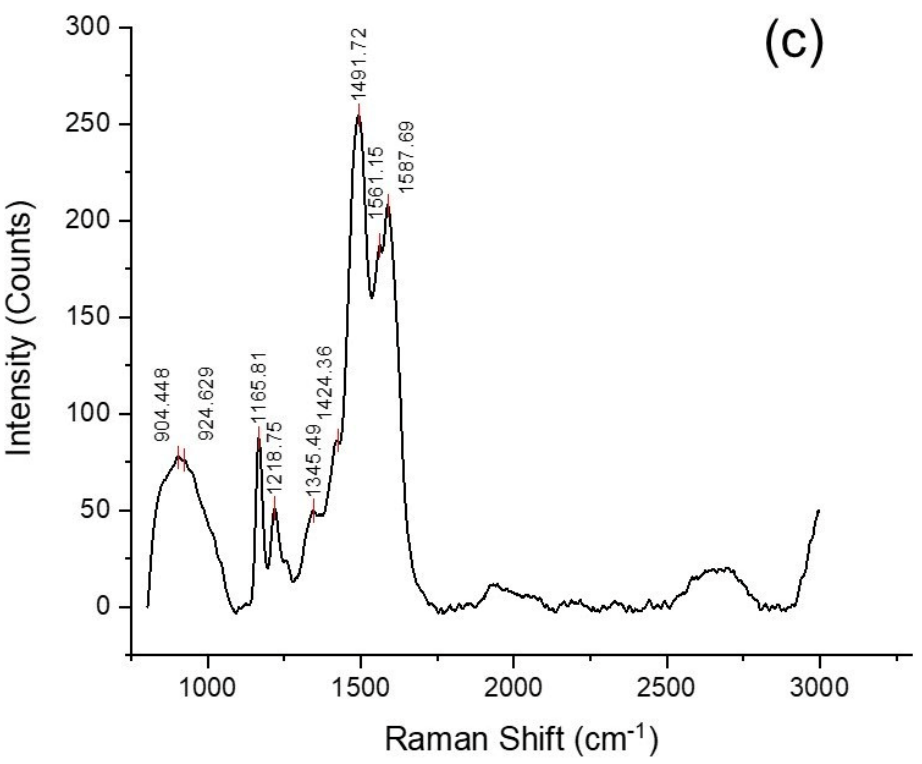
Figure 2. ( a ) XRD spectrum, ( b ) FTIR spectrum, and ( c ) Raman spectrum of the semi-poly-crystalline polyaniline.